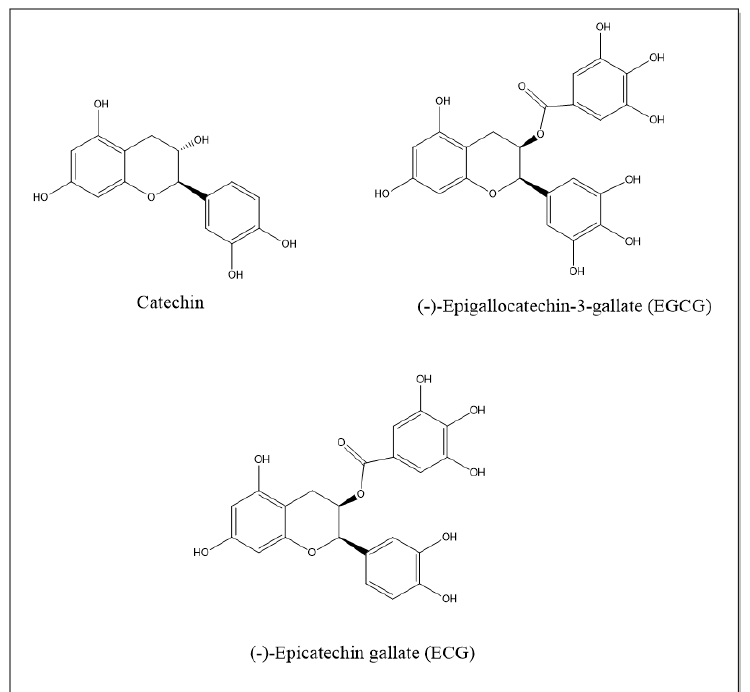
Figure 1. Chemical structure of reno-protective